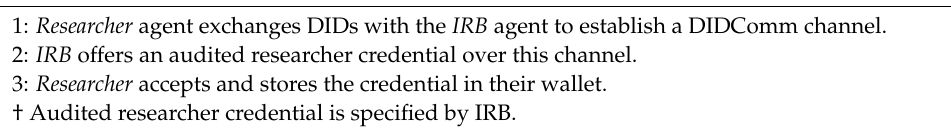
Algorithm 1 Establishing Trusted Connections